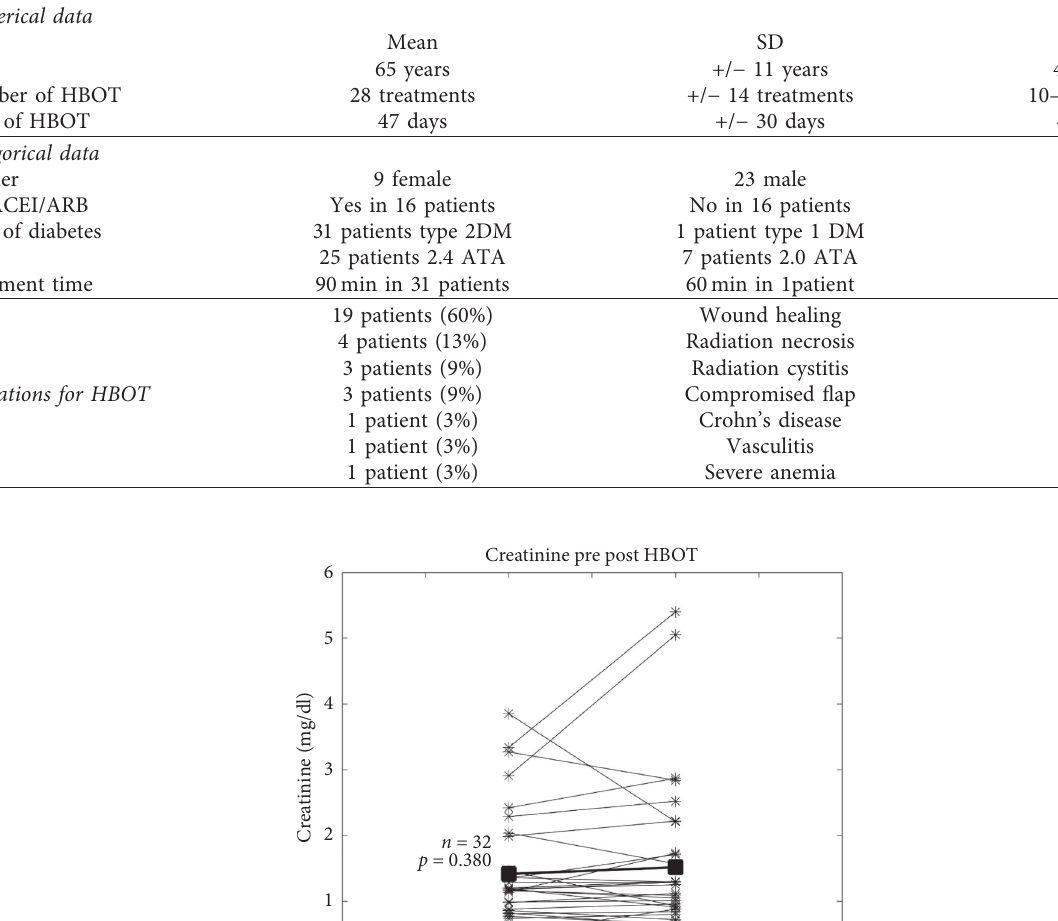
Table 1: Characteristics of the patients.